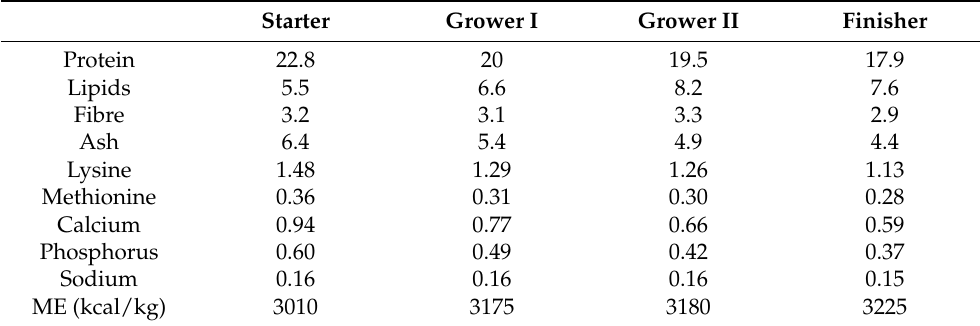
Table 1. Chemical composition (% as it is) and metabolizable energy calculated (ME) of the feeds administered to chickens in both poultry houses.